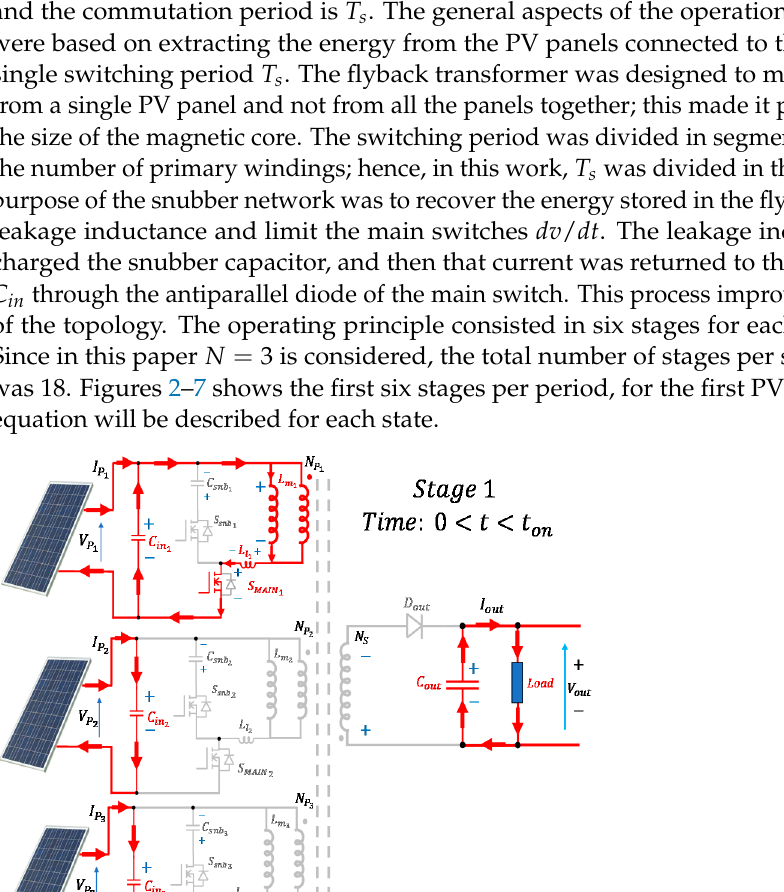
Figure 2. Stage 1, time: 0 < t < t on . 2.2. Stage 2: 𝑡 (cid:3042)(cid:3041) < 𝑡 ≤ 𝑡 (cid:2869)